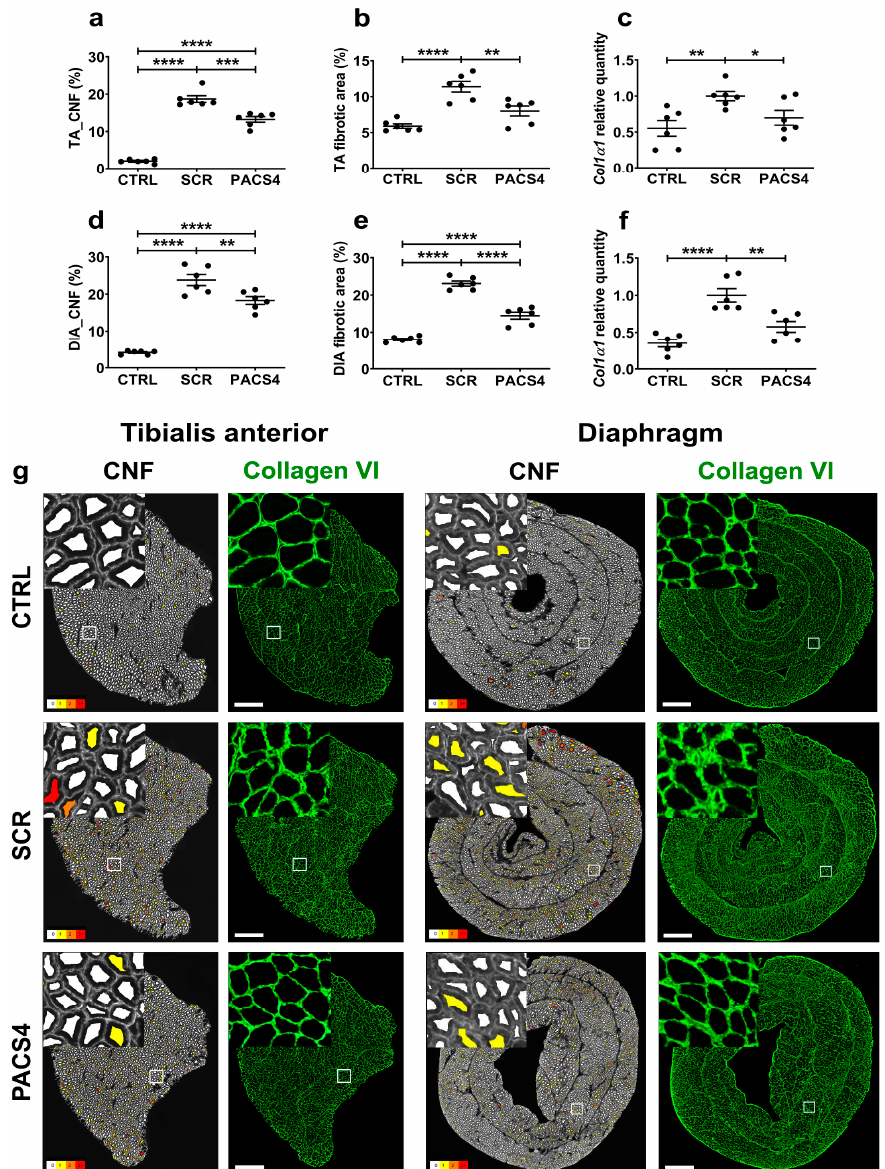
Figure 5. vivoPMO-PACS4 treatment reduces muscle deterioration and muscle fibrosis. The tibialis anterior (TA) and diaphragm (DIA) muscle sections were stained for laminin or collagen VI; DAPI was used for nuclear staining. The total number of centrally nucleated myofibers (CNFs) of ( a ) TA and ( d ) DIA muscles was scored automatically and is expressed as a percentage of the total myofiber number within the same transverse muscle section. Fibrotic area in ( b ) TA and ( e ) DIA muscles was semi-automatically evaluated and expressed as percentage of the area positive for collagen VI of the muscle CSA. mRNA expression of Col1 α 1 indicative for fibrotic response in ( c ) TA and ( f ) DIA muscles was quantified by qRT-PCR as relative to Gapdh and shown as a fold-change of SCR values obtained by the same way. Data are shown as means ± SEM; n = 6. Statistical comparison was by one-way ANOVA followed by Tukey’s multiple comparisons test; * p < 0.05, ** p < 0.01, *** p < 0.001, **** p < 0.0001. ( g ) Representative images of the entire muscle cross-sections analyzed by Fiji/MuscleJ for CNFs, with fibers having 0, 1, 2 and 3+ CNFs color-coded as white, yellow, orange and red, respectively. Images of transverse muscle sections immunostained with collagen VI are shown at a magnification of × 100, scale bar = 500 µ m. Corresponding enlarged images at higher magnification are shown in the